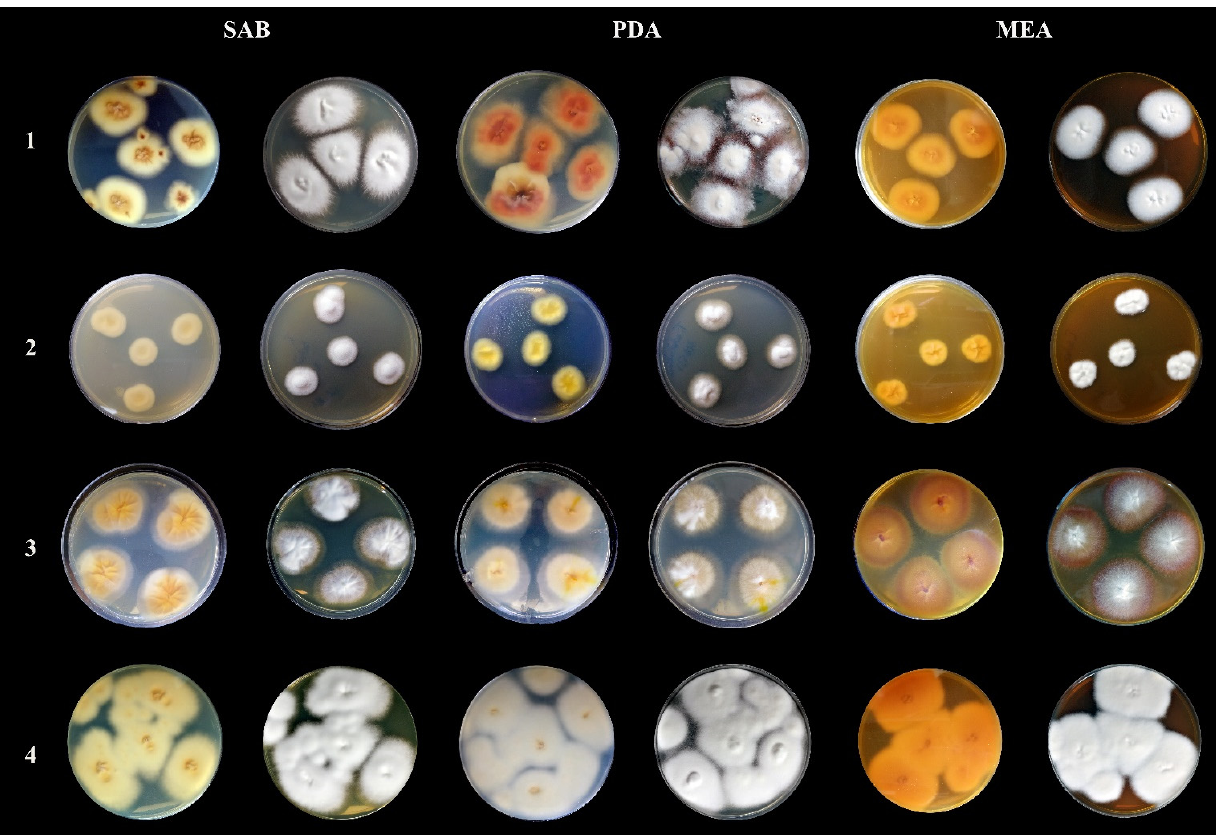
Figure 3. Macromorphological characteristics of Trichophyton quinckeanum compared with other species of dermatophytes classified under the genus Trichophyton . All photos show colonies from a 14- day culture at 25 °C. Mycological media: SAB—Sabouraud glucose agar, PDA—potato dextrose